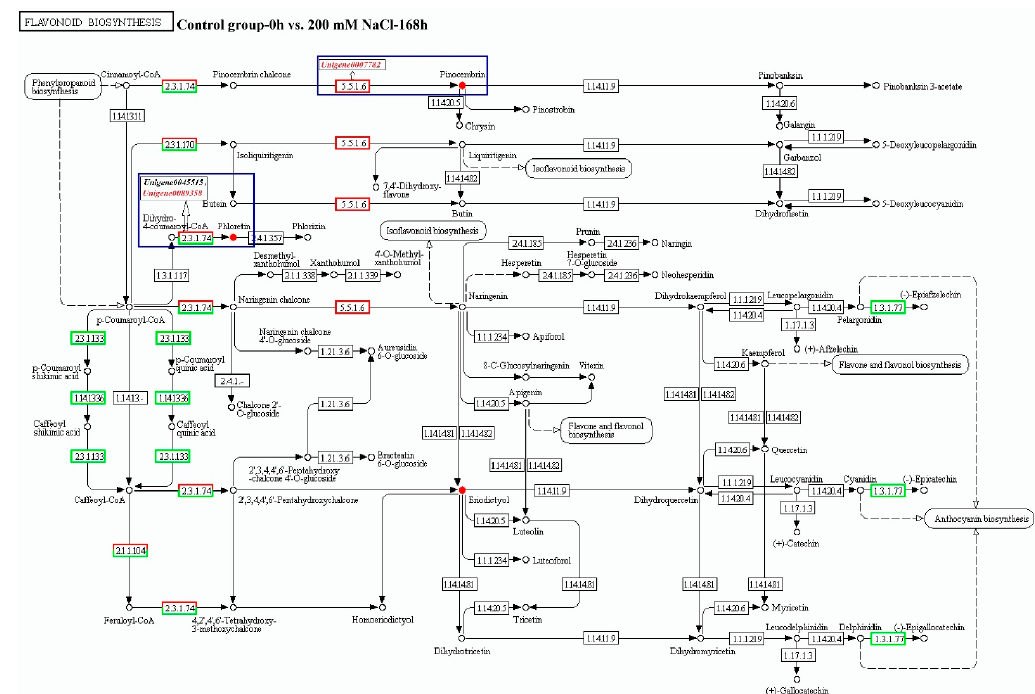
Figure 3. Flavonoid biosynthesis pathway annotated with DEGs and differential metabolites. (DEGs and metabolites annotated on the flavonoid biosynthesis pathway in the roots of T . ramosissima at 48 and 168 h under NaCl stress. Note: blue box: DEGs regulate their related differential metabolites; red genes: DEGs upregulated; black genes: DEGs downregulated; red differential metabolites: differential metabolite accumulation; green differential metabolites: differential metabolite degradation.